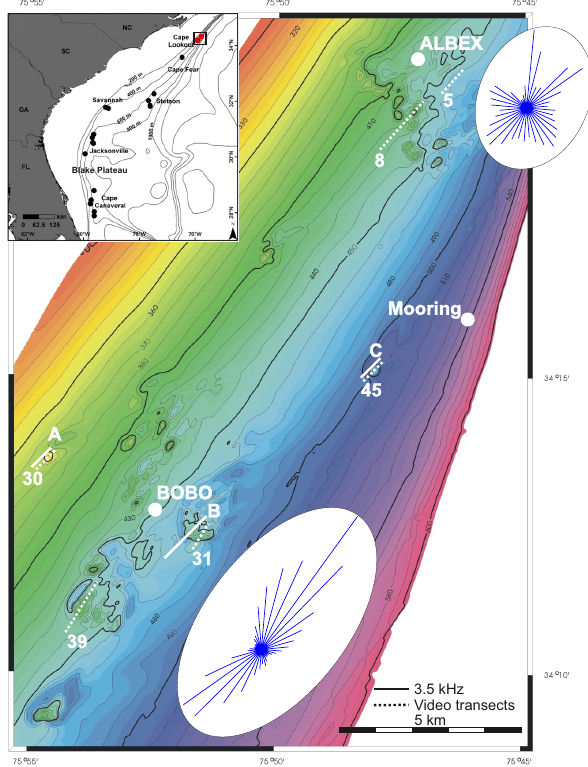
Fig. 1. Multibeam bathymetry map of the research area with 3.5kHz profiles, video transects, mooring and lander locations indicated. Vector plots of displacement (ellipses) relative to the lander position show the direction and magnitude of the transport of water. Inset shows the general CWC areas that have been recorded in the West